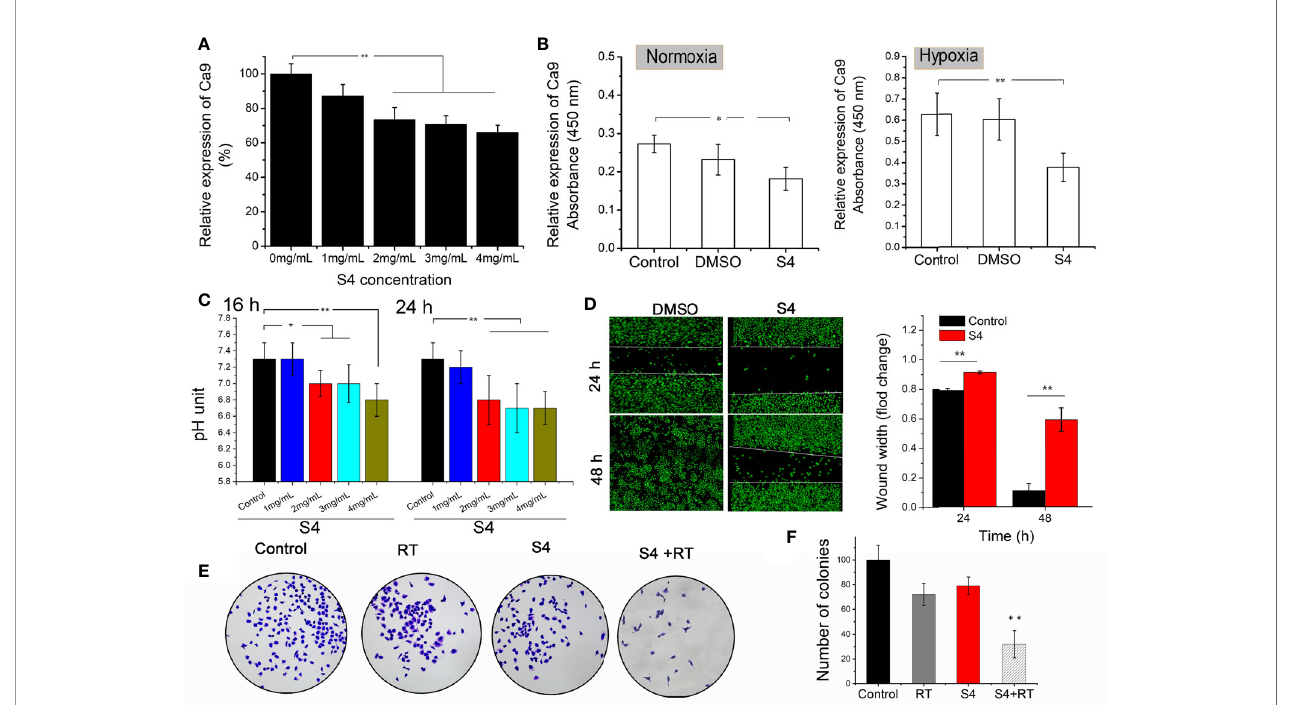
FIGURE 3 | Effect of S4 treatment on CAIX expression, intracellular pH, and migration capacity of ECA-109 cells. (A) ECA-109 cells were treated with S4 at various doses (0, 1, 2, 3, and 4 mg/mL) for 12 h under normoxic conditions. The expression level of CAIX in each group of cells was measured by ELISA. (B) ECA-109 cells were incubated with or without S4 (4 mg/mL) or DMSO for 12 h under normoxic or hypoxic conditions. The expression level of CAIX was assessed by ELISA. (C) ECA-109 cells were treated with or without S4 at different concentrations (1, 2, 3, and 4 mg/mL) under hypoxic conditions. The intracellular pH was measured by at 16-h or 24-h post-treatment. (D) Transwell assay was performed to evaluate the migration capacity of ECA-109 cells treated with or without S4 (4 mg/mL) for 24 or 48 h. (E, F) Cells were treated with or without 200 m L of PBS or S4 (2 mg/mL) for 4 h and then irradiated with 4 Gy X-ray and incubated for 12 days to form cell clones. Subsequently, cells were stained with 0.1% crystal violet and the number of colonies were counted under a microscope. *P < 0.05, ** P <